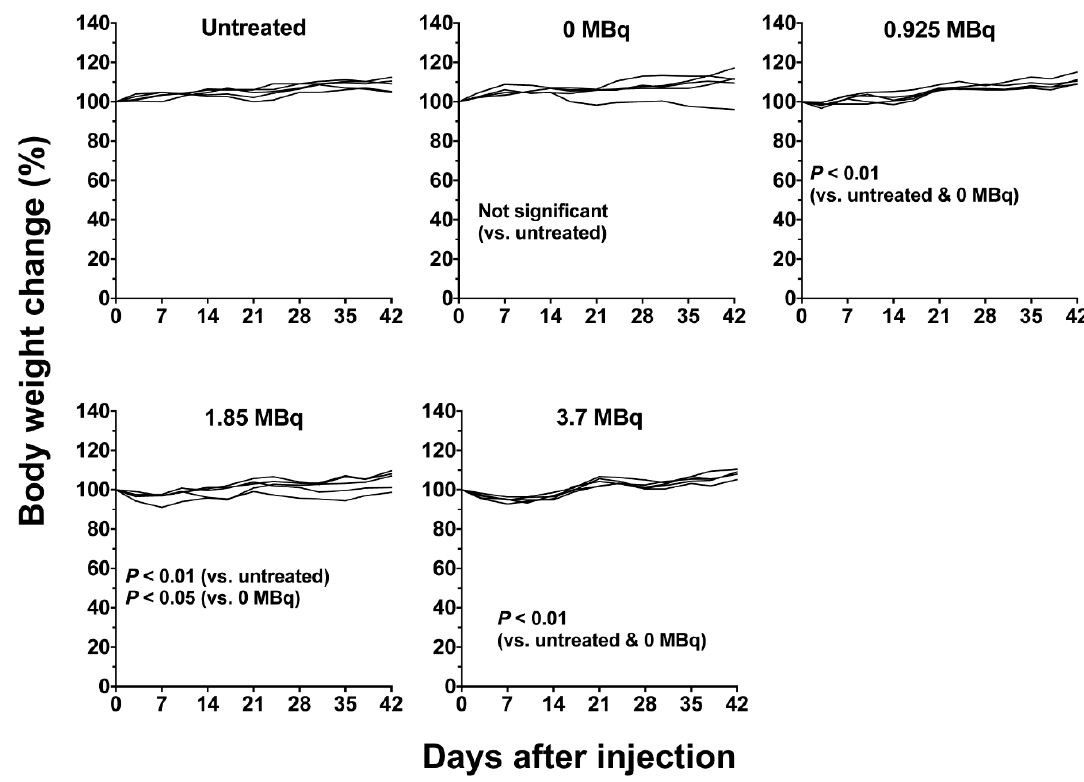
Figure 4. Individual body weight curves of mice bearing BxPC-3 tumors injected with 90 Y-labeled anti-CD147 antibody 059-053. The injected doses were 0 (intact antibody only), 0.925 MBq, 1.85 MBq and 3.7 MBq of 90 Y-059-053. Body weight was measured at least twice a week.